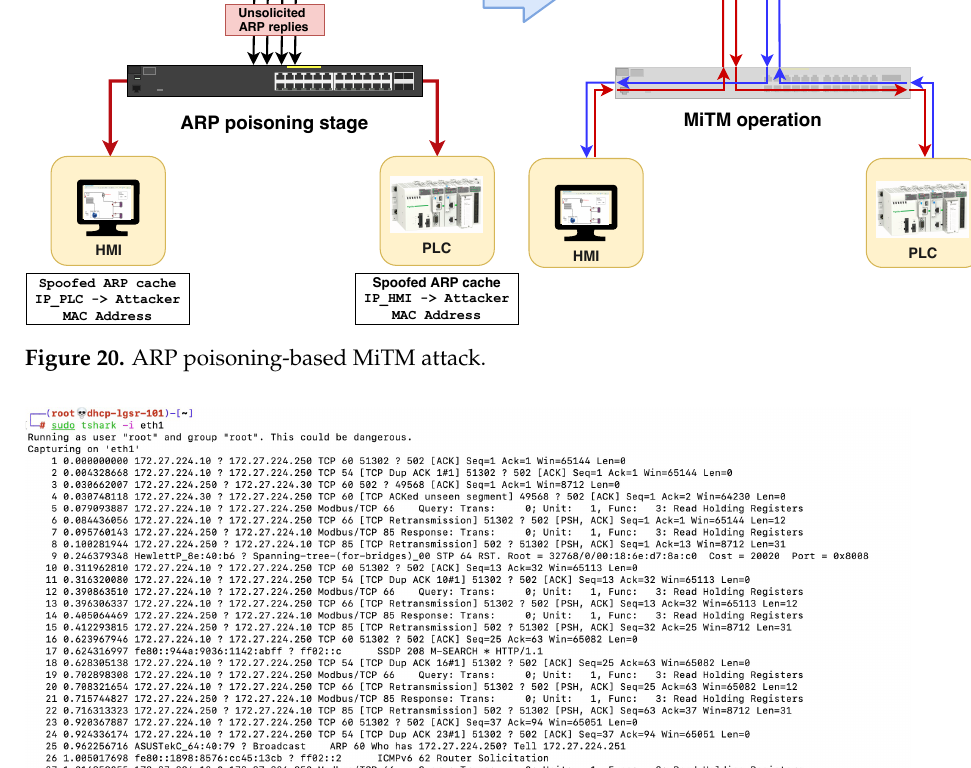
Figure 21. Traffic sniffing during ARP MiTM session.